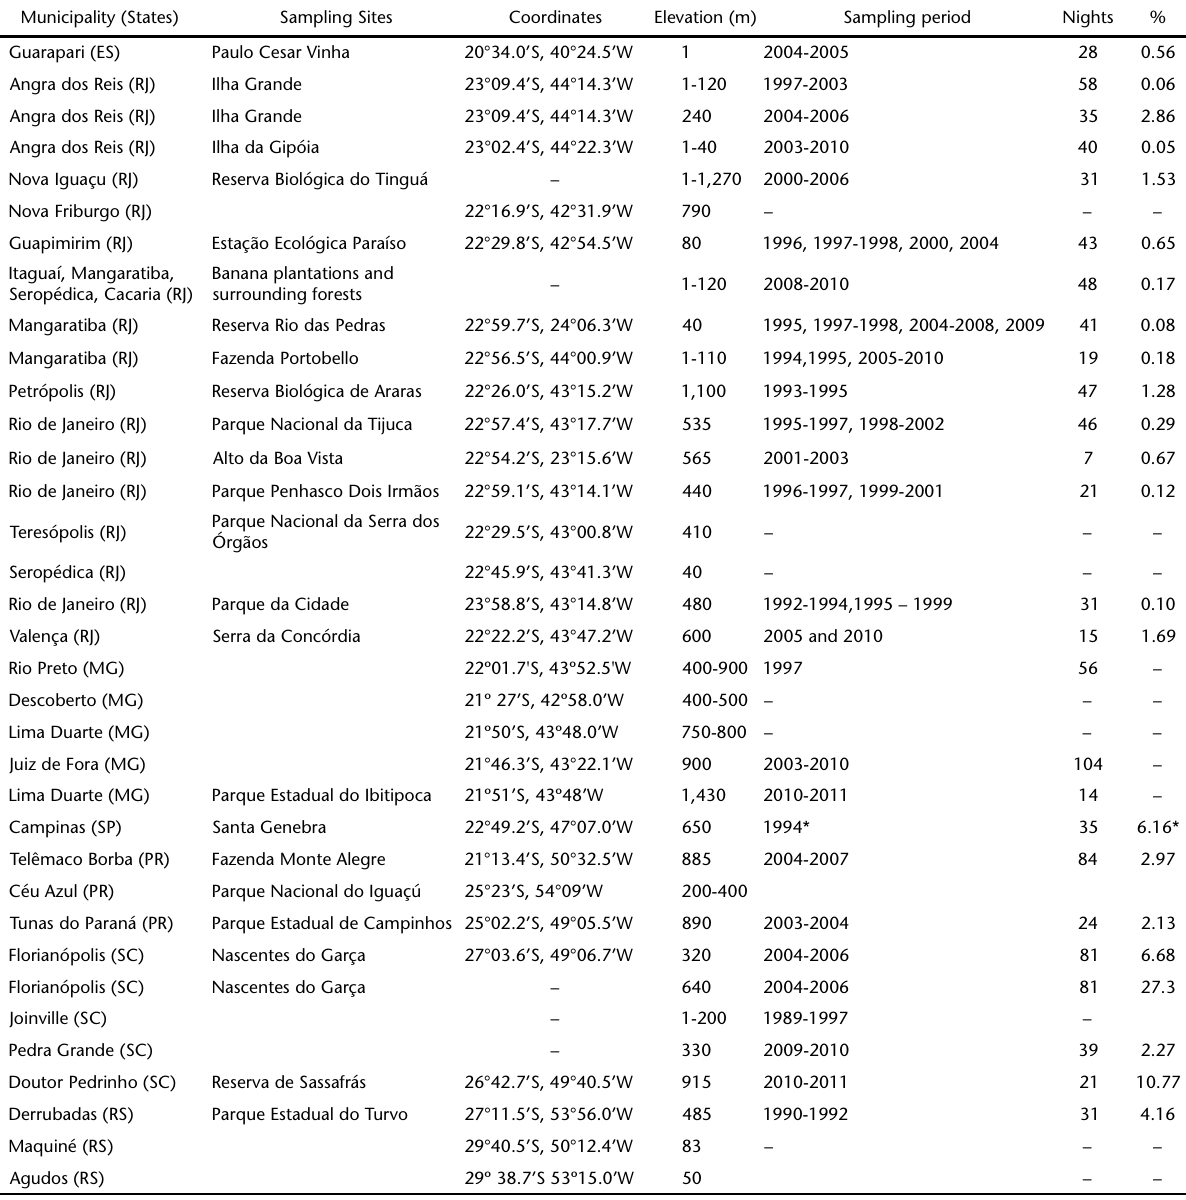
Table I. Percentage of captures of Pygoderma bilabiatum in different municipalities and states in southeastern and southern Brazil. For each site we inform its geographical coordinates, elevation (m), sampling period, and number of sampling nights. Parentheses indicate years with sampling at monthly intervals; other years were sampled